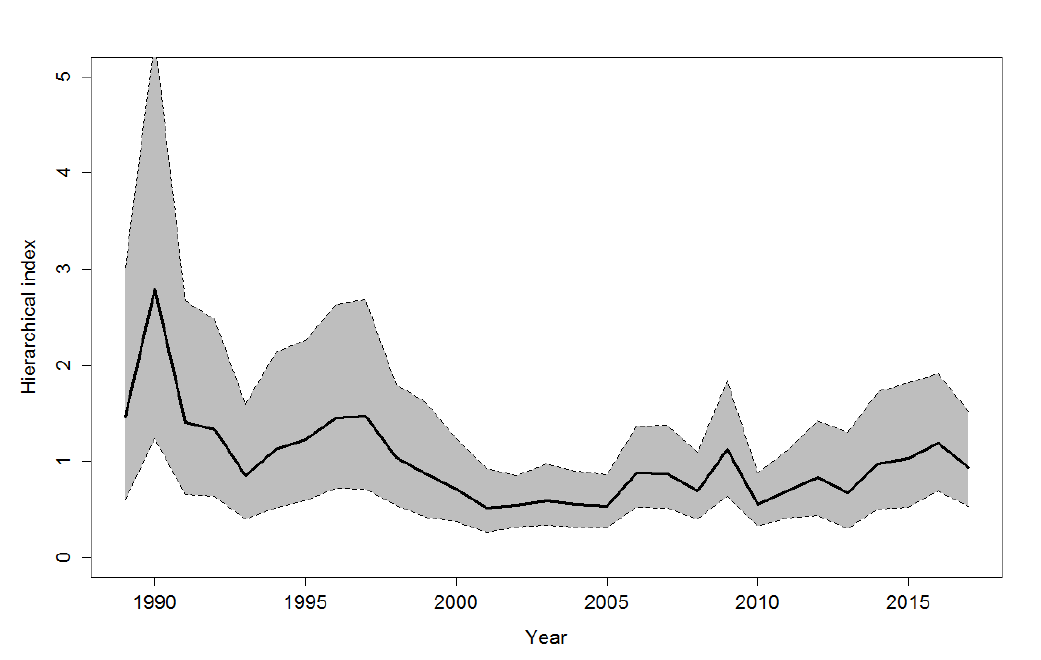
Figure 80. Time series of female horseshoe crab relative abundance in the Delaware Bay region as estimated from the hierarchical analysis. The black line gives the posterior mean and the grey, shaded area represents a 95% credible interval about the time